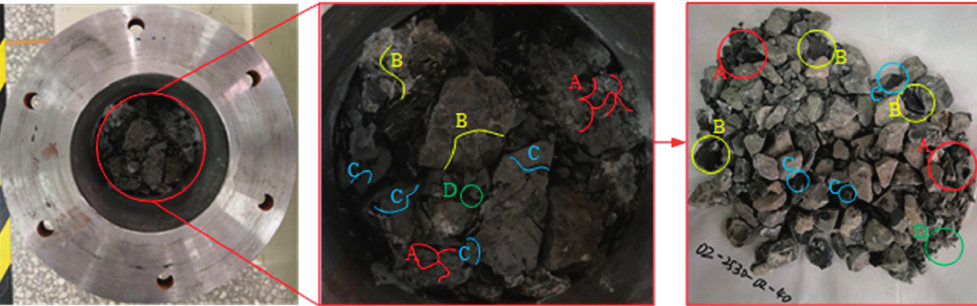
Figure 7: The breakage characteristics after compaction. Table 3: The change in particle content under different loading speeds for samples with different